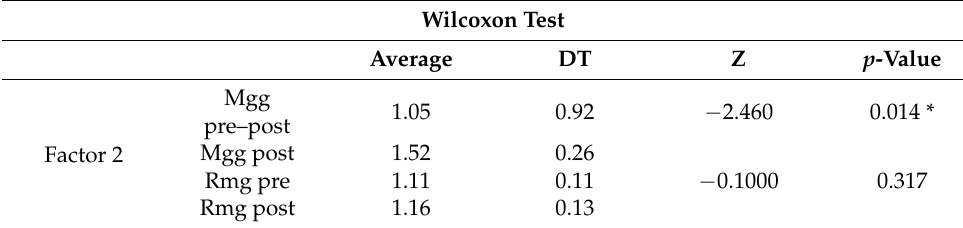
Table 3. Wilcoxon test applied to Factor 2 (Immersion).